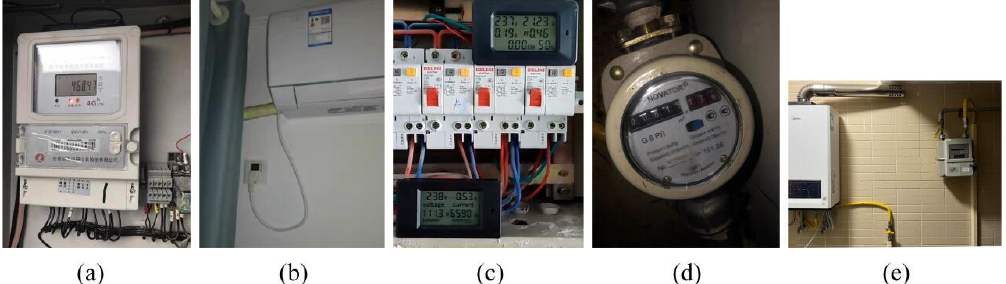
Figure 3. Installation of the energy measurement system: ( a ) kilowatt-hour meter for total household power, ( b ) smart power plug for cooling, ( c ) kilowatt-hour meter for lighting and appliances, ( d ) gas meters for cooking, ( e ) gas meters for domestic hot water (DHW). Table 4. Details of the measurement instruments.